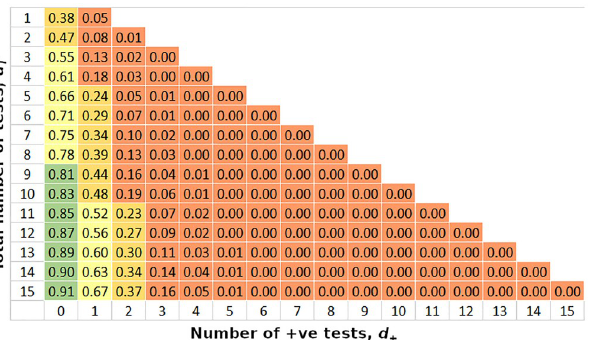
Fig 4. Probability of greater efficiency using pooling, as a function of the number of exploratory tests and the number of positive results. The exploratory diagnostic test is assumed to have a sensitivity that varies smoothly from 30% for the lowest prevalence to 70% for the highest. Prior knowledge of prevalence is uninformative. Pool size = 5. Green = > 80%, yellow = 80% - > 50%, orange = 50% - > 20%, red < =